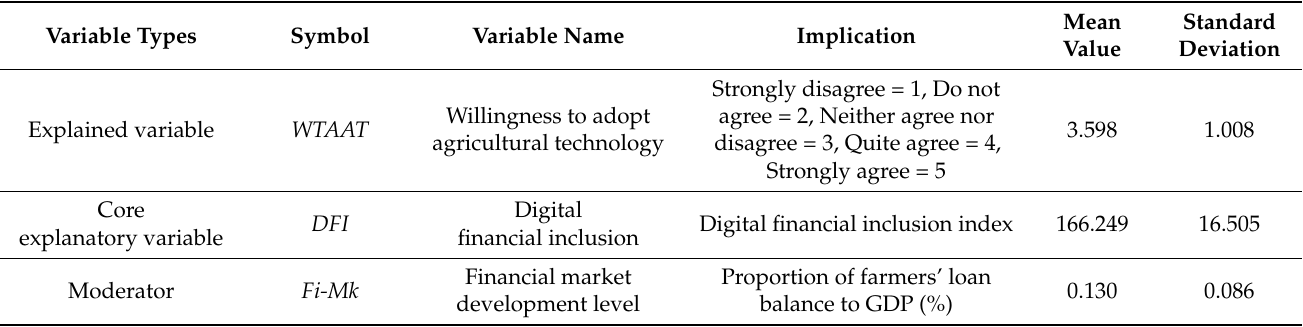
Table 1. Definition of variables and descriptive statistical analysis